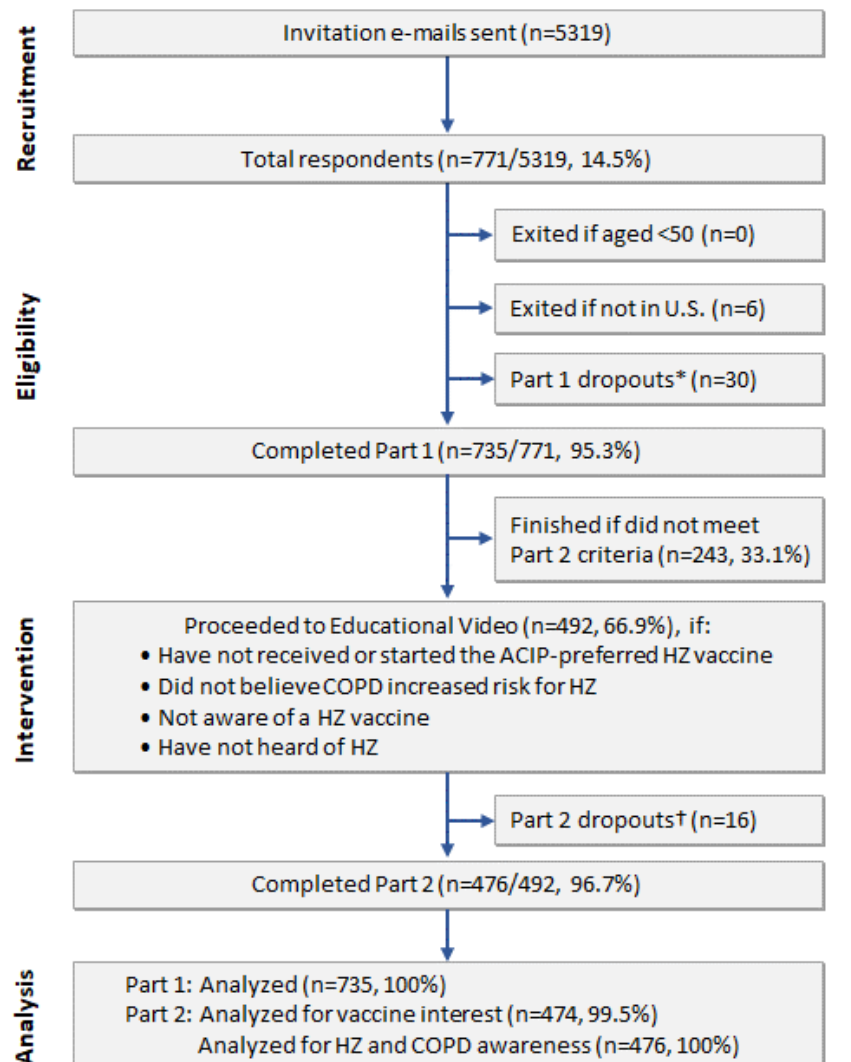
Figure 1. Flow diagram of participant disposition in the Shingles Patient Prevention Study (ShiPPS).